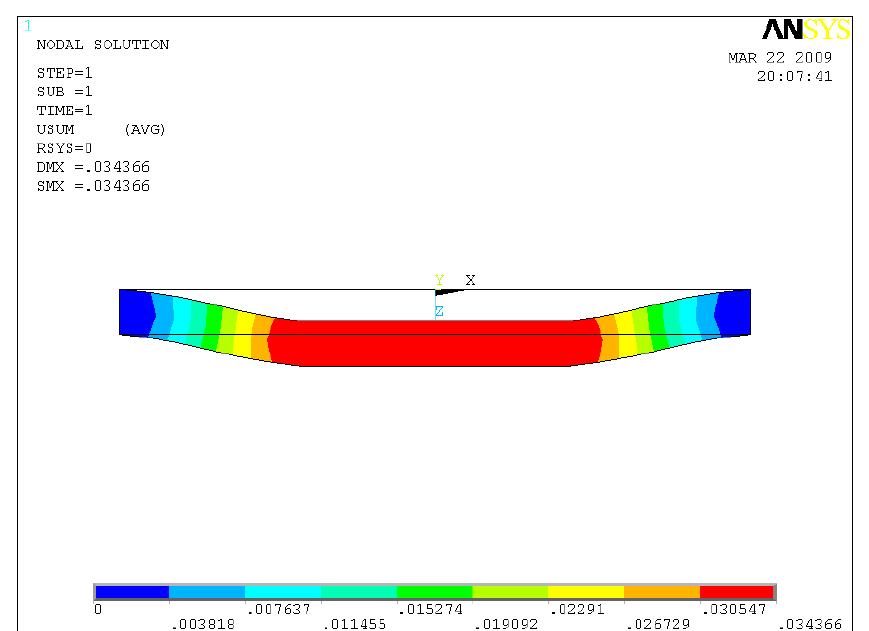
Figure 4. PDMS membrane deflection under the magnetic